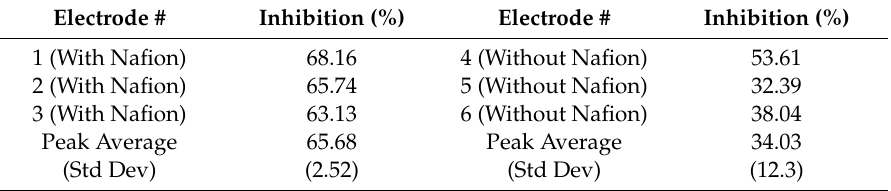
Table 2. Average percentage of malathion inhibition of Configuration #1 with Nafion.